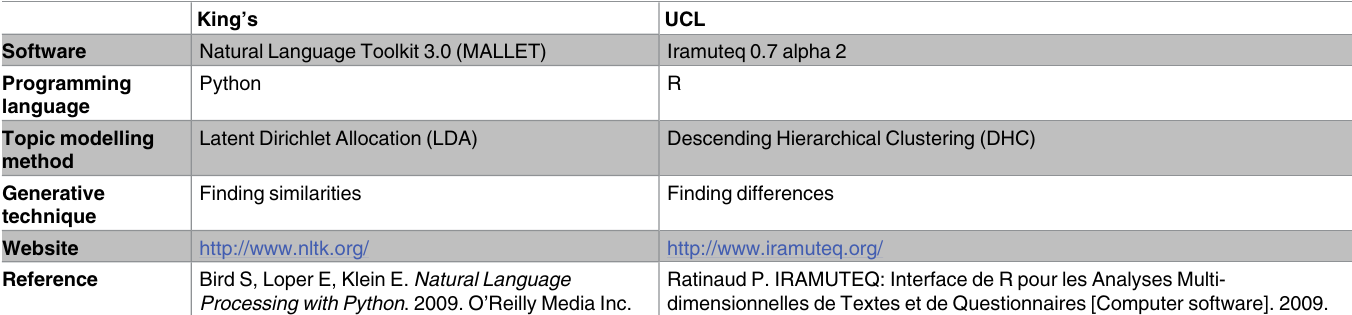
Table 1. Comparison of the text mining methods used in the King’s [34] vs. UCL analysis. King’s